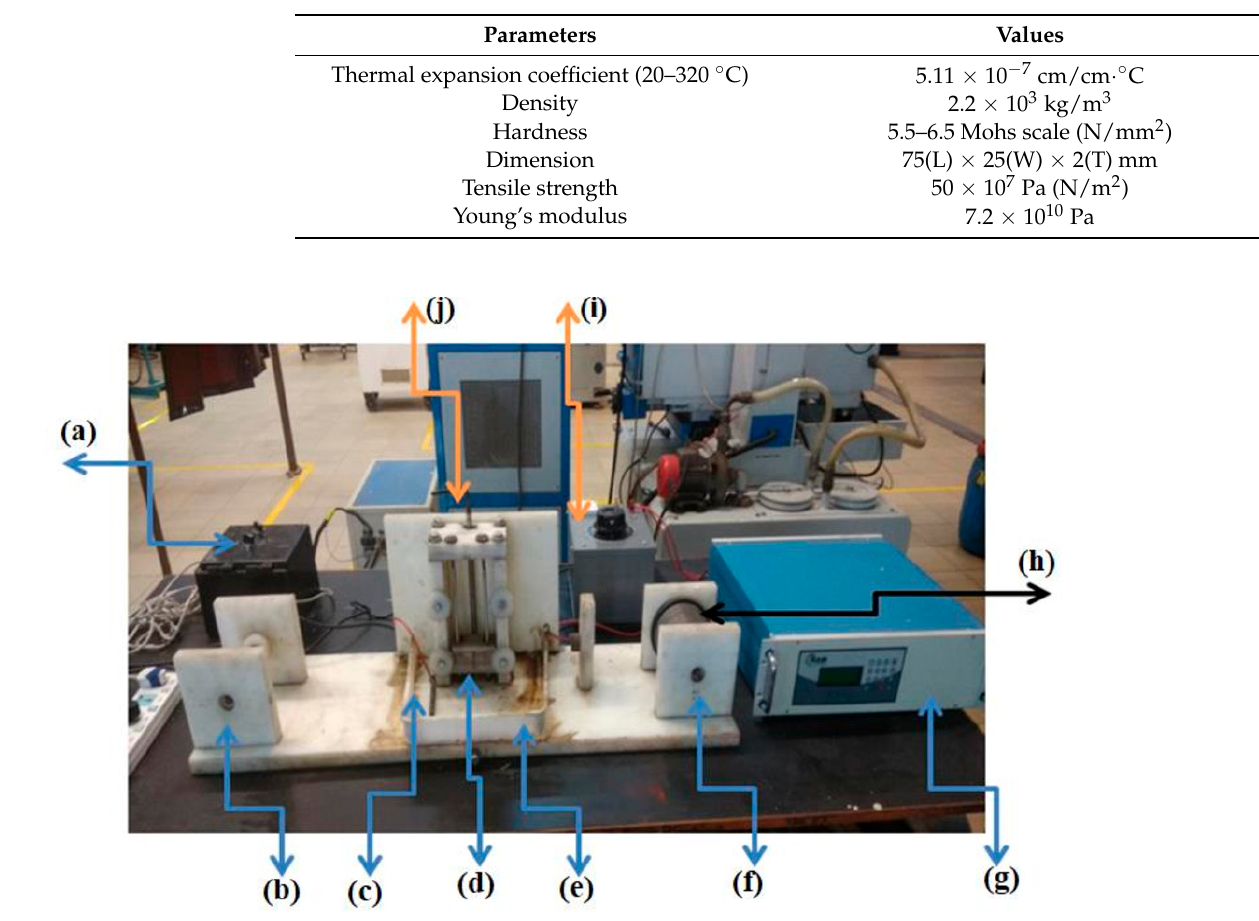
Figure 2. The TW-ECDM setup.